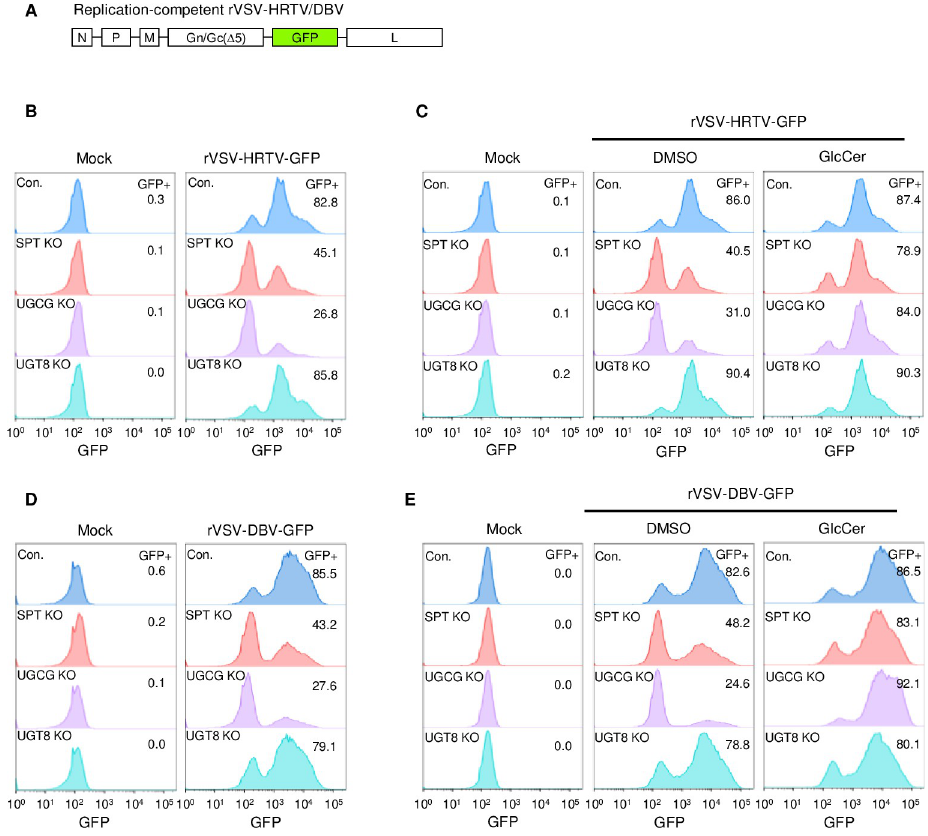
Fig 8. Replication-competent HRTV or DBV pseudotyped viruses require GlcCer for efficient entry. A. Diagram of replication-competent rVSV-DBV genome. B. Replication-competent rVSV-HRTV entry in SPTLC2-, UGCG- or UGT8-deficiency cells. Control and KO 293T cells were infected with replication-competent rVSV-HRTV for 16 hours, followed by flow cytometry. C. Rescue of replication-competent rVSV-HRTV entry in SPTLC2-, UGCG- or UGT8-deficiency cells. Control and UGCG-KO 293T cells were cultured in media supplemented with 50 μ M DMSO or GlcCer for 24 hours, followed by infection with replication-competent rVSV-HRTV for 16 hours prior to flow cytometry assay. D. Replication-competent rVSV-DBV entry in SPTLC2-, UGCG- or UGT8-deficiency cells. E. Rescue of replication-competent rVSV-DBV entry in SPTLC2-, UGCG- or UGT8-deficiency cells. The experiments were performed similarly as described